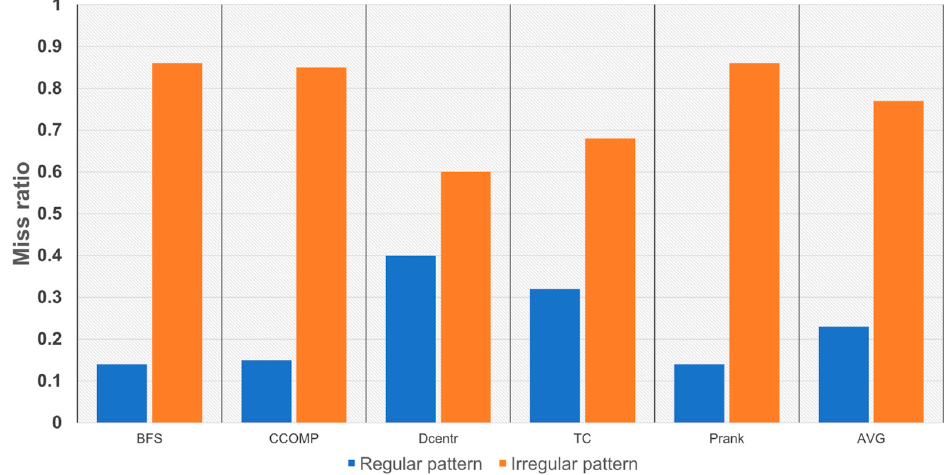
Figure 1. Miss ratio from different patterns for graph- processing workloads.